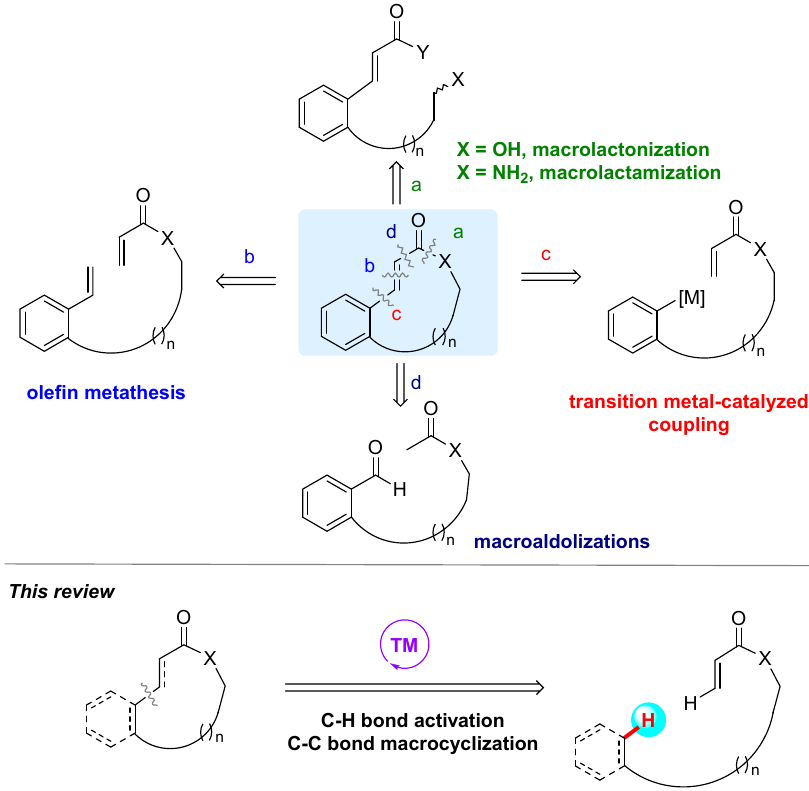
Figure 2. General strategies for the direct synthesis of macrocycles.